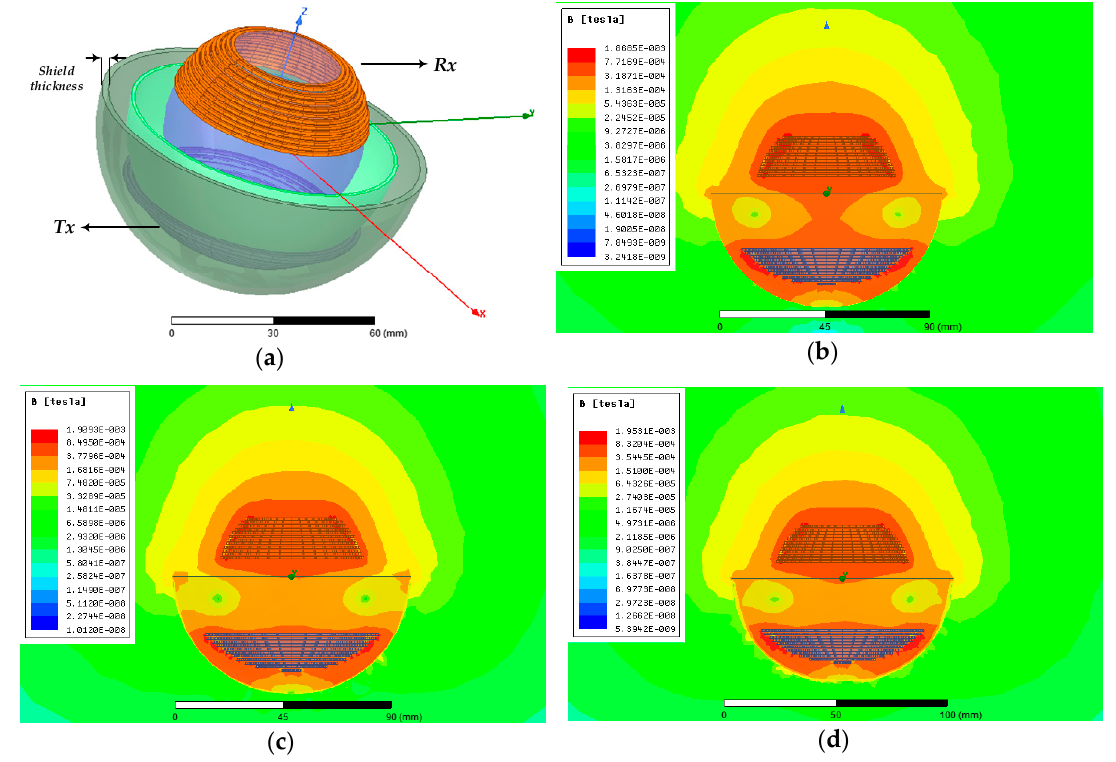
Figure 17. Joint–WPT system: ( a ) aluminum sheet (AL shield) for Tx only; ( b ) 0.3-mm AL shield; ( c ) 1-mm AL shield; ( d ) 2-mm AL shield.